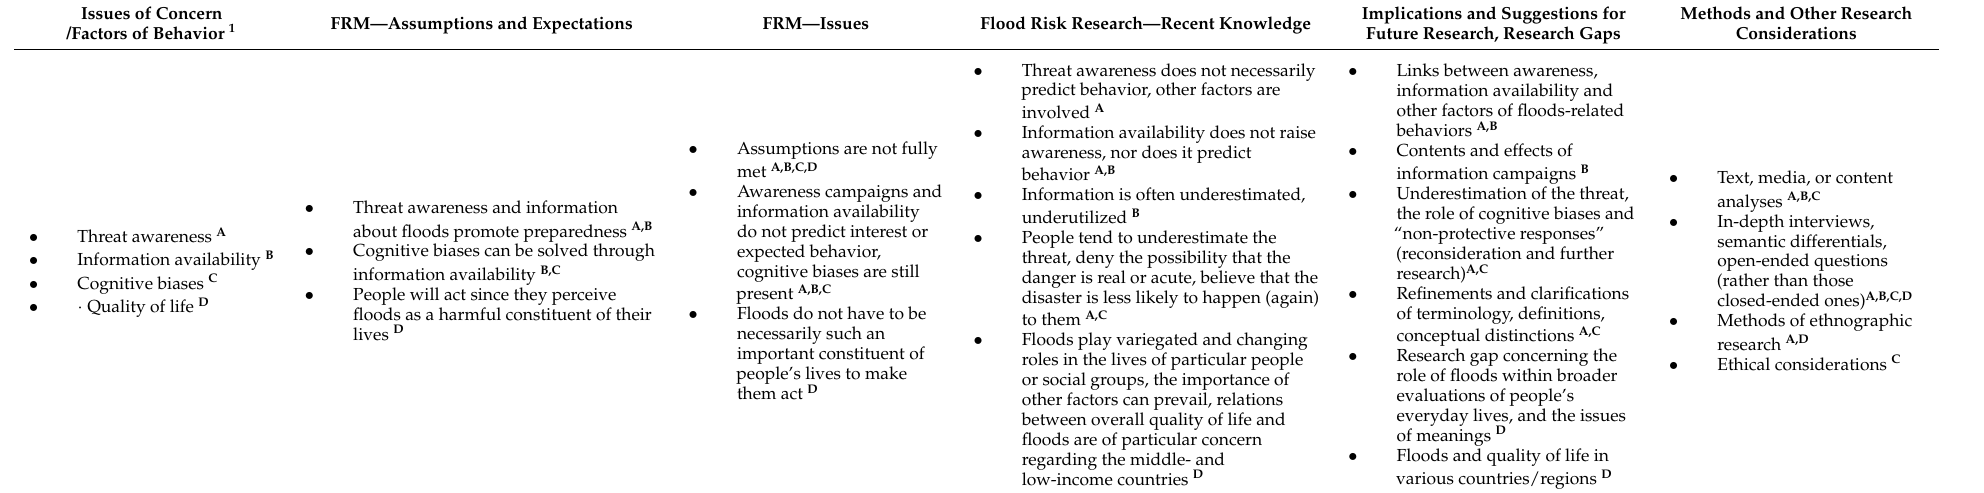
Table 4. Risk perception—overview of findings, implications, and suggestions for future flood risk research